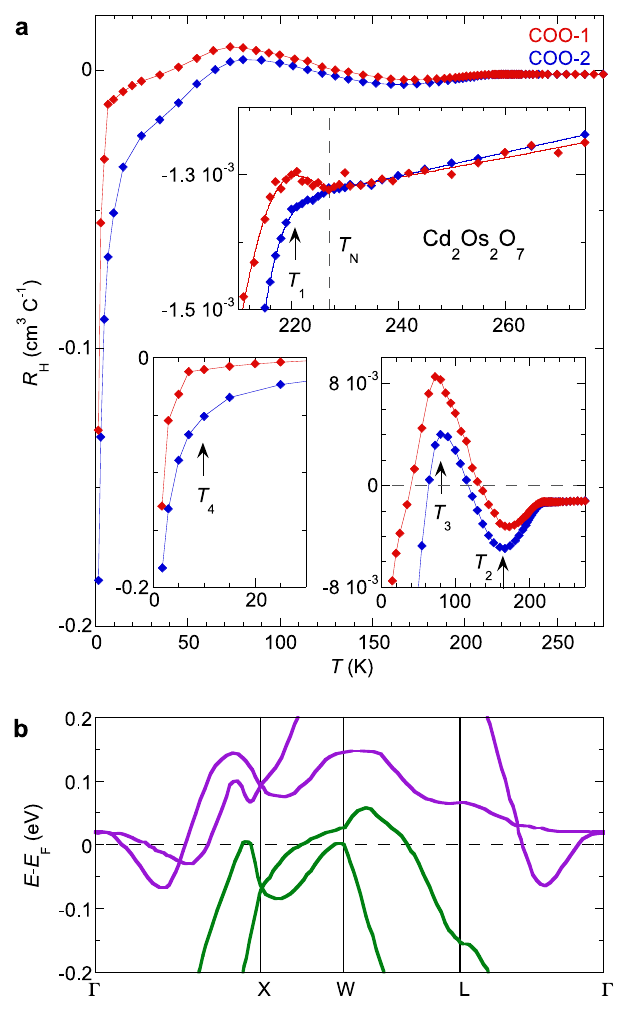
Fig. 3 Metal − insulator transition in Cd 2 Os 2 O 7 revealed through bulk Hall coef fi cient. a Temperature evolution of the bulk Hall coef fi cient R H ( T ) from two Cd 2 Os 2 O 7 samples COO-1 and COO-2 in Fig. 2g are compared in detail. While R H ( T ) evolves slowly above T N , it starts to deviate from the high-temperature behavior right at T N , indicating that the onset of AIAO antiferromagnetic order in fl uences the band structure around the Fermi level. Nevertheless, R H ( T ) does not diverge until it reaches a temperature below 10 K ~ 0.044 T N when the true charge gap opens. In between, each sharp change in R H ( T ) (close-up view of the main fi gure in individual insets) indicates a band leaving the Fermi level, marked by arrows at four different temperatures, T 1 = 220 K, T 2 = 165 K, T 3 = 80 K, and T 4 = 10 K. Two bands are of hole type and the other two of electron type. All statistical uncertainties are smaller than the symbols. b Band structure of Cd 2 Os 2 O 7 near the Fermi level. ð E (cid:3) E F Þ along trajectories between reciprocal space points Γ , X, W, and L are adapted from calculations in ref. 26 . The four bands, two of hole (green) and two of electron (purple) types, are sequentially driven away from the Fermi level by the increasing strength of antiferromagnetic order to form a band